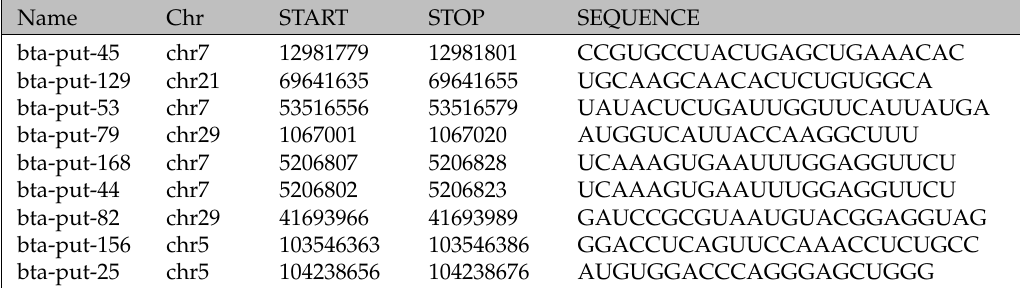
Table 4. Novel expressed miRNAs, predicted and expressed miRNAs identified from read data based on read count and secondary structure according to the miRPara (miRNA prediction software tool) classification score. The description of chromosomal location is shown with Chr (chromosome), start and